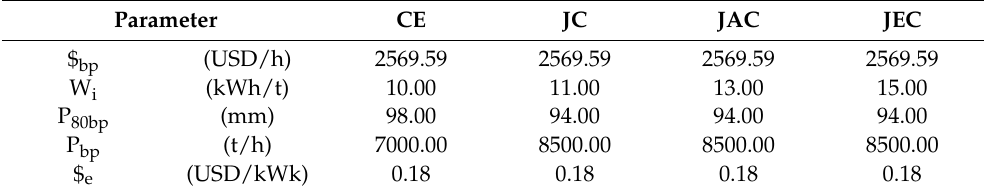
Table 4. Mean parameters used for the model calibration process for primary crushing at the truckless